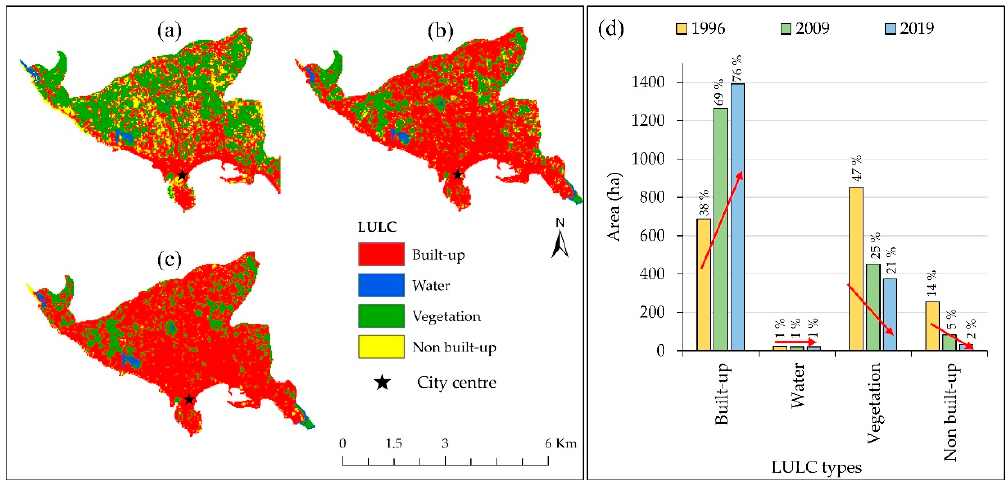
Figure 2. Land use and land cover (LULC) map of the Galle Municipal Council area (GMCA): ( a ) LULC in 1996, ( b ) LULC in 2009, ( c ) LULC in 2019, and ( d ) temporal changes of LULC from 1996 to 2019.